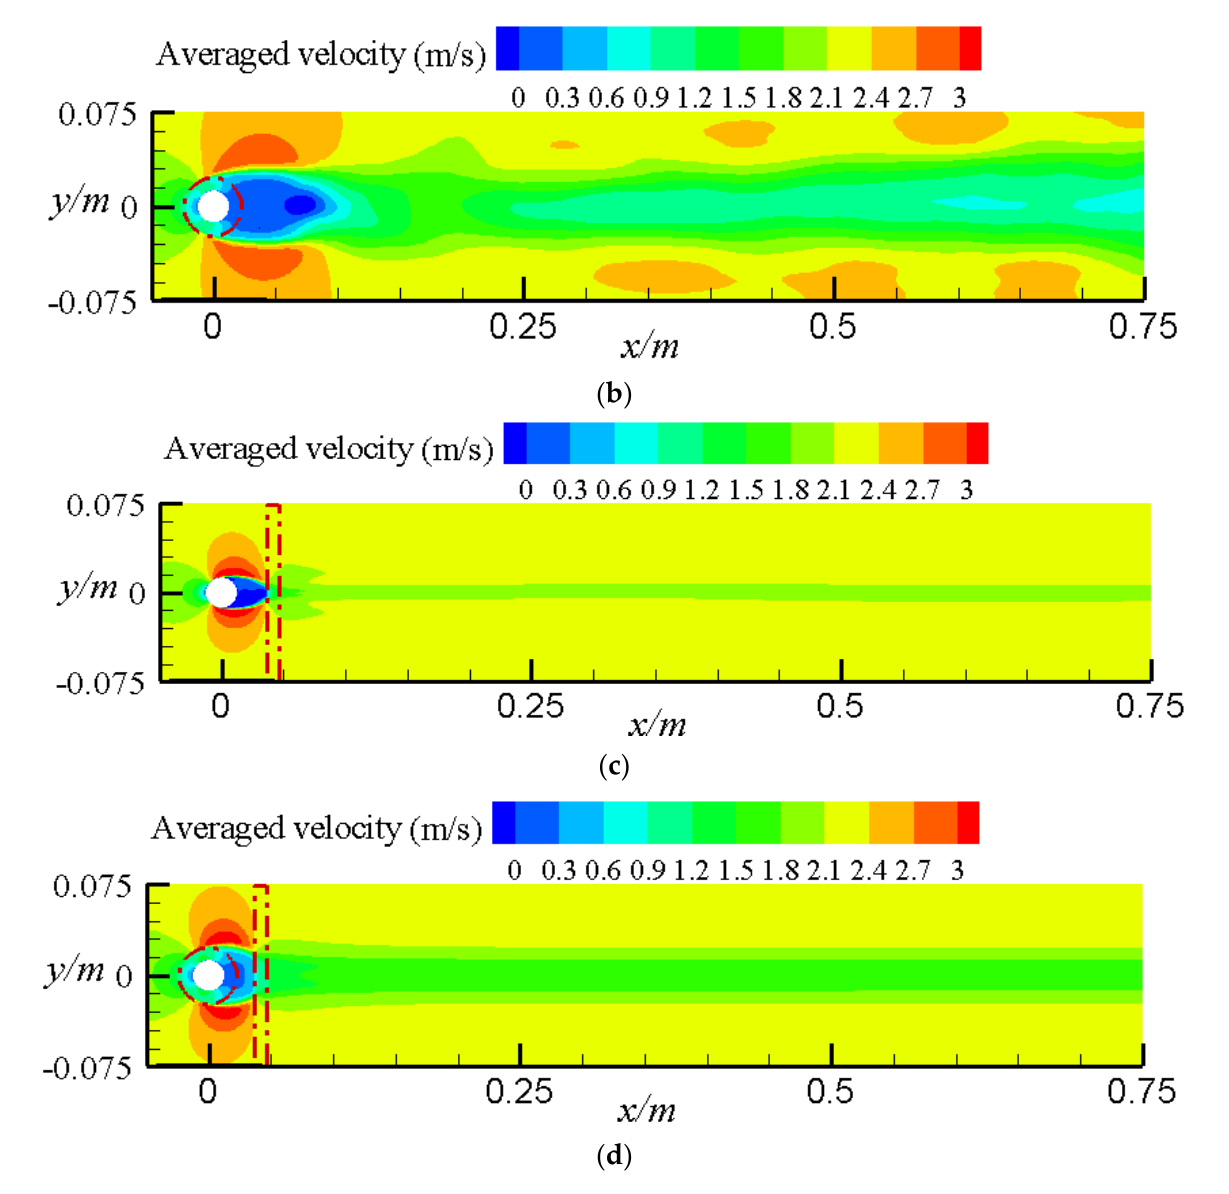
Figure 14. Streamwise time-averaged velocity contour at Z = 0 plane: ( a ) Cylinder; ( b ) PC; ( c ) CP; ( d ) PCP.